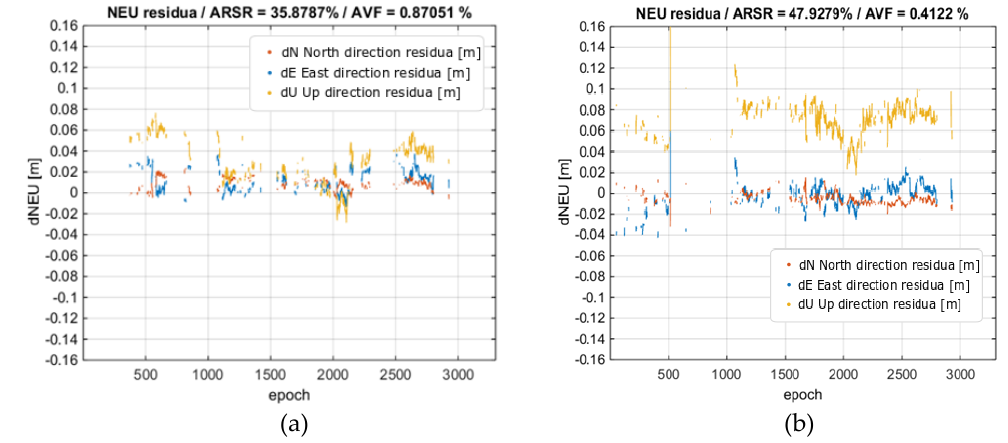
Figure 10. Rover position residua vs. the reference solution from processing DZIA baseline. ( a ) No ionospheric corrections; ( b ) With ionospheric corrections. Horizontal residuals are in red and blue, and height residuals are in yellow.